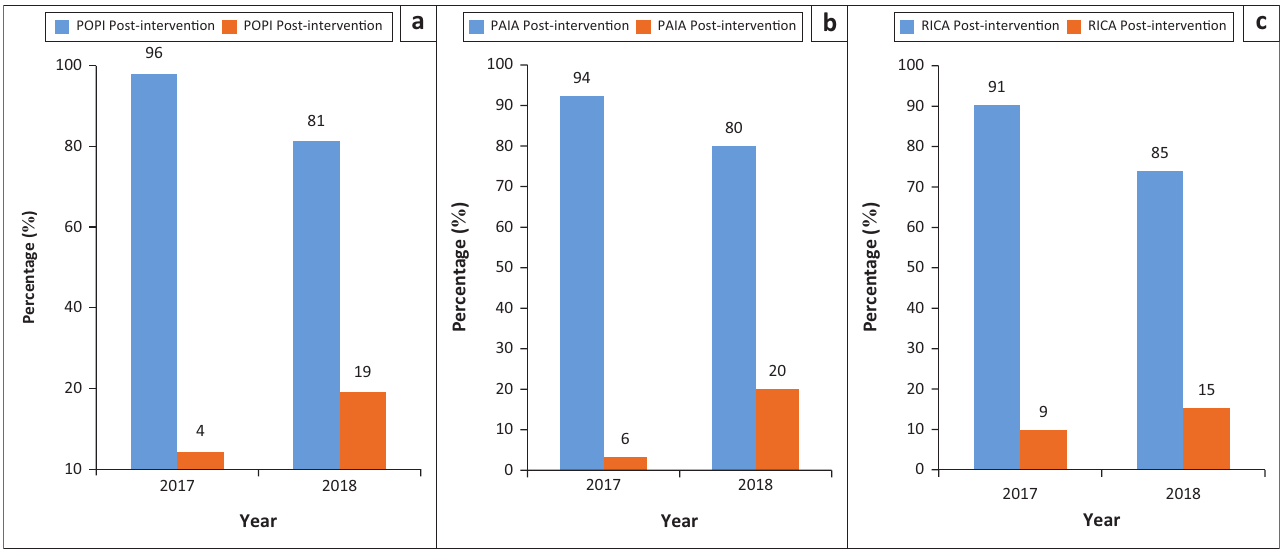
POPI, Protection of Personal Information ; PAIA, Promotion of Access to Information Act ; RICA, Regulation of Interception of Communication Act .